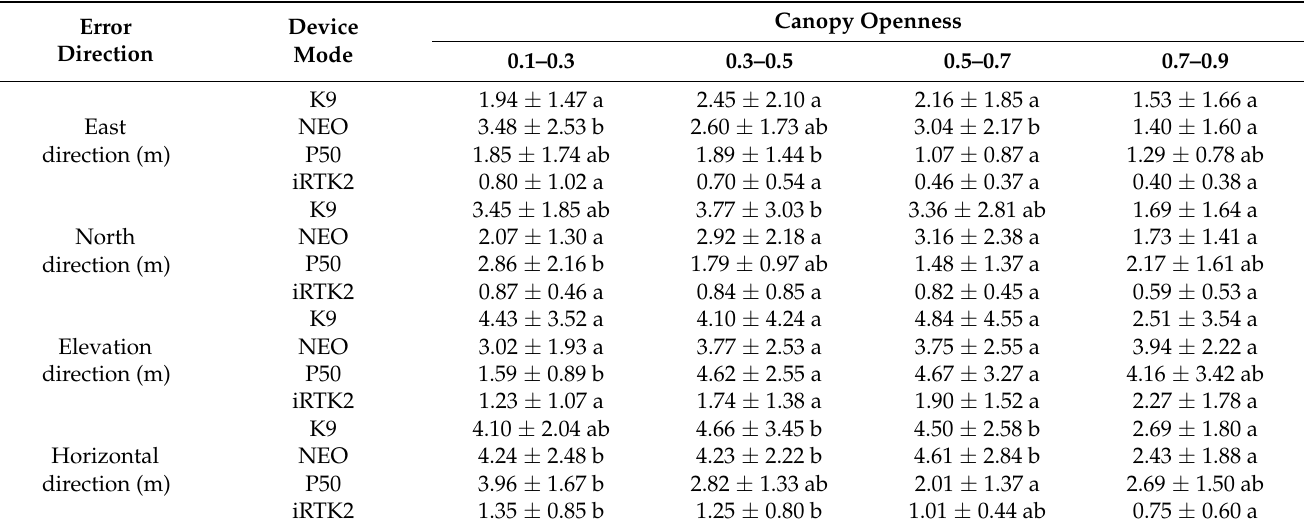
Table 6. Positioning accuracy of each device in precise-point positioning (PPP)